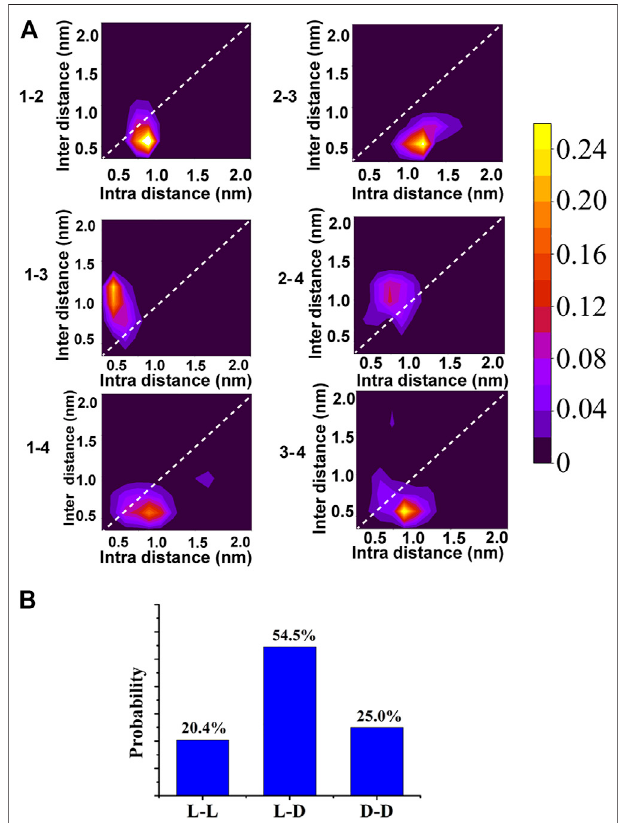
FIGURE 6 | (A) The probability map of structures sampled for every two monomers in one of the fi ve simulated mixed systems. Samples are projected into intra-distance (distance between the two monomers) and inter-distance (the nearest distance between the other monomers and either of the two monomers). The probability value corresponding to each color was shown in the color bar. (B) The normalized probabilities of the nearest distance attributing to L-L, L-D, D-D.